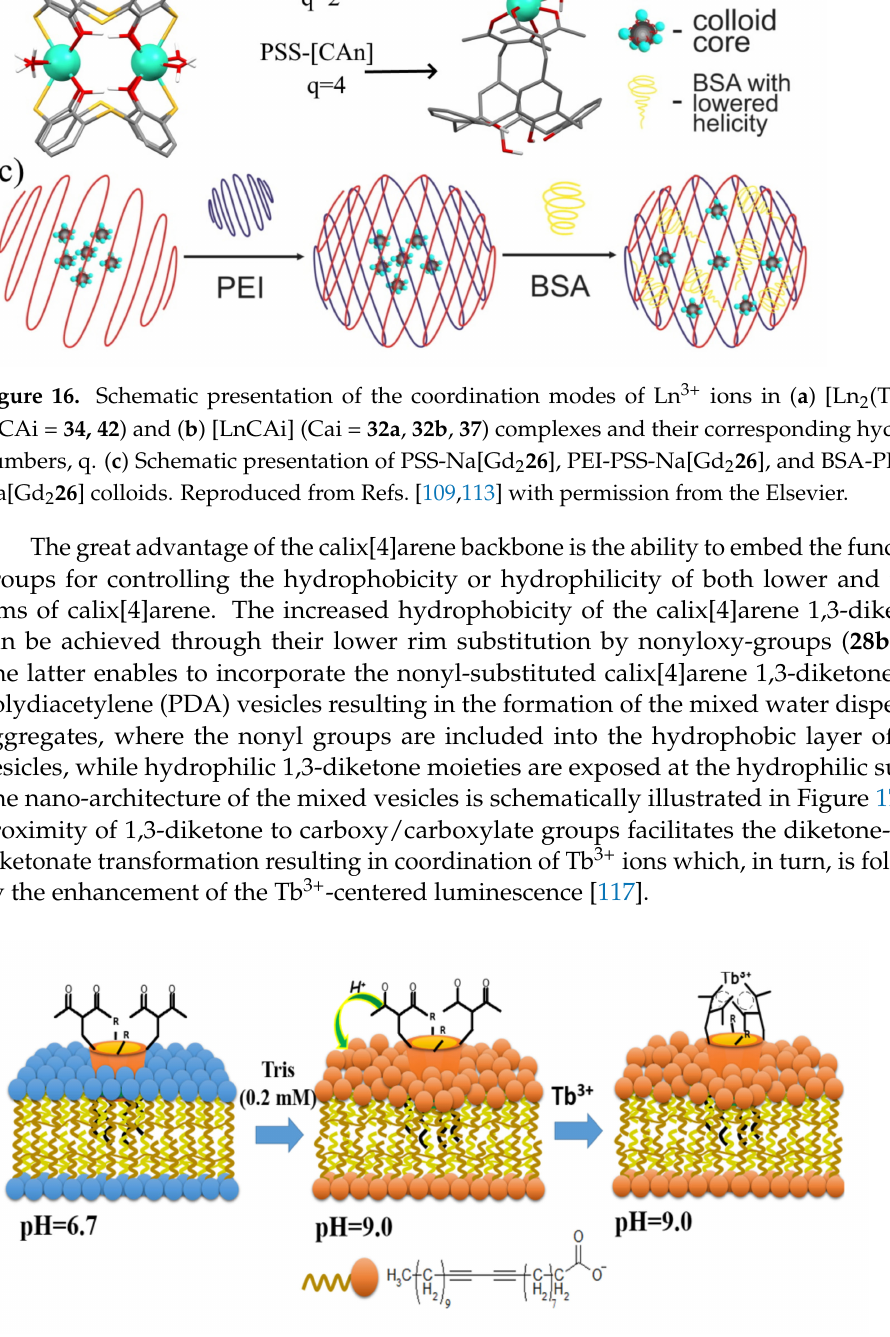
Figure 17. Schematic illustration of proton-pump effect of the carboxylate-groups of polydiacetylene (PDA)-vesicles on the coordination of Tb 3+ ions via 1,3-diketonate groups of 28b and 41d embedded into the PDA vesicles. Reproduced from Ref. [117] with permission from the